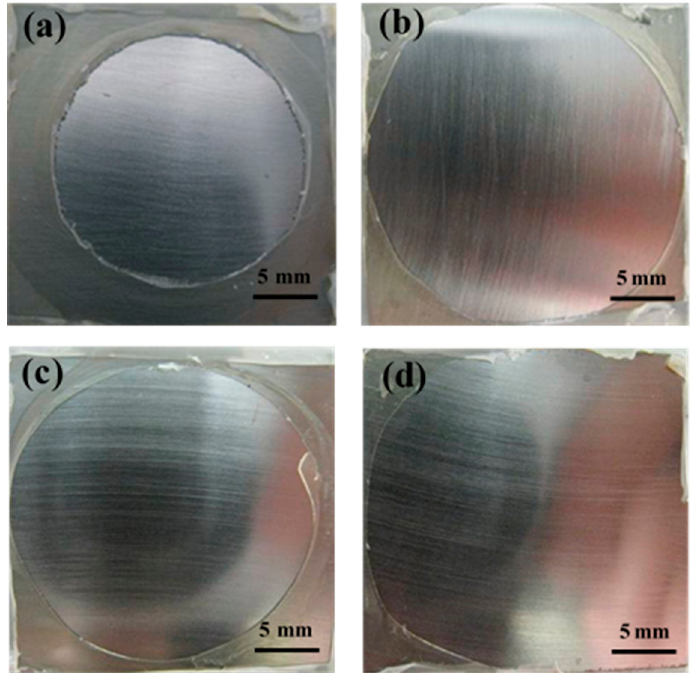
Figure 5. Macroscopic fracture morphology pictures of EV coating/steel under two pressure conditions at different immersion times: ( a ) after immersion 48 h under ordinary pressure; ( b ) 192 h under ordinary pressure; ( c ) 48 h under hydrostatic pressure and ( d ) 192 h under hydrostatic pressure.